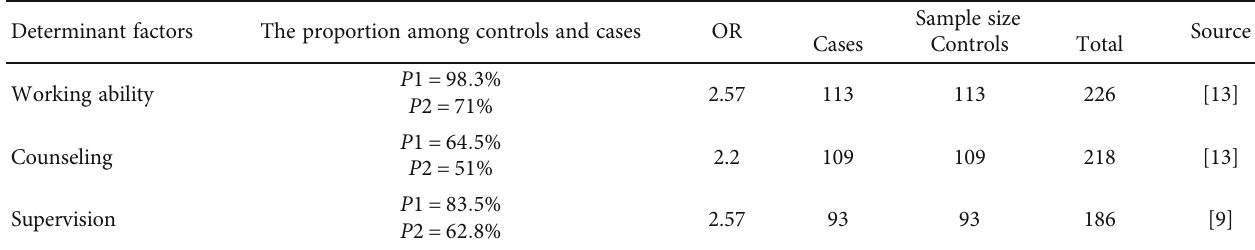
Table 1: Determinant factors of weight gain among adult TB patients during intensive phase taken from previous studies, 2020. Determinant factors